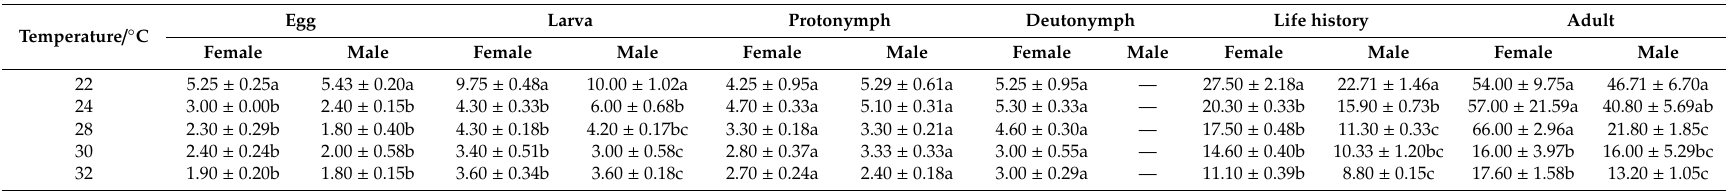
Table 1. Development time of C. malaccensis reared at di ff erent temperatures under laboratory conditions (M ± SD) (d). Temperature / ◦